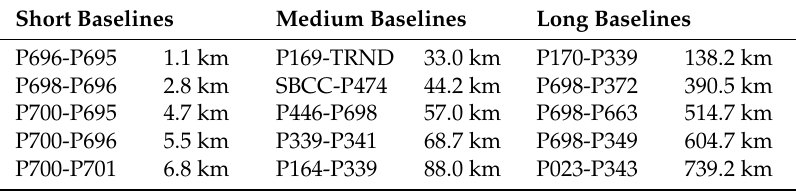
Figure 2. Distribution of stations at the mid latitudes. The small map shows the stations constituting short baselines and the larger one is for medium-to-long baselines. Table 3. Length information of the short, medium and long baselines at mid latitudes.